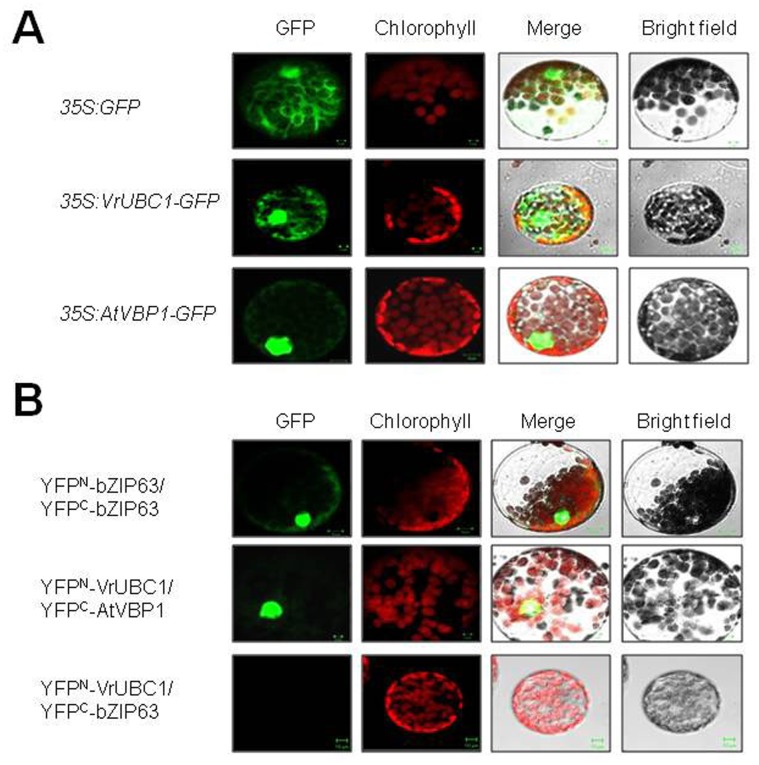
Subcellular localization of GFP-fusion proteins and BiFC visualization of the interaction between VrUBC1 and AtVBP1 in Agrobacterium-infiltrated tobacco (Nicotiana benthamiana).(A) The 35S:GFP, 35S:GFP-AtVBP1, and 35S:AtVrUBC1-GFP constructs were transformed into tobacco leaves via Agrobacterium-infiltration. Protoplasts were isolated from the infiltrated leaves after 36 h. Localization of fusion proteins was visualized by confocal microscopy. (B) YFPN fusions of VrUBC1 and YFPC fusion of AtVBP1 were coexpressed in tobacco leaves as previously described [66]. Epifluorescence from the interaction between YFPN fusions of VrUBC1 and YFPC fusion of AtVBP1 was observed in the nucleus of the protoplasts (scale bar = 20 µm). BiFC of Arabidopsis bZIP63 dimerization is shown as an interaction control as previously described [66]. Coexpression of YFPN-VrUBC1/YFPC-bZIP63 is shown as a negative control.